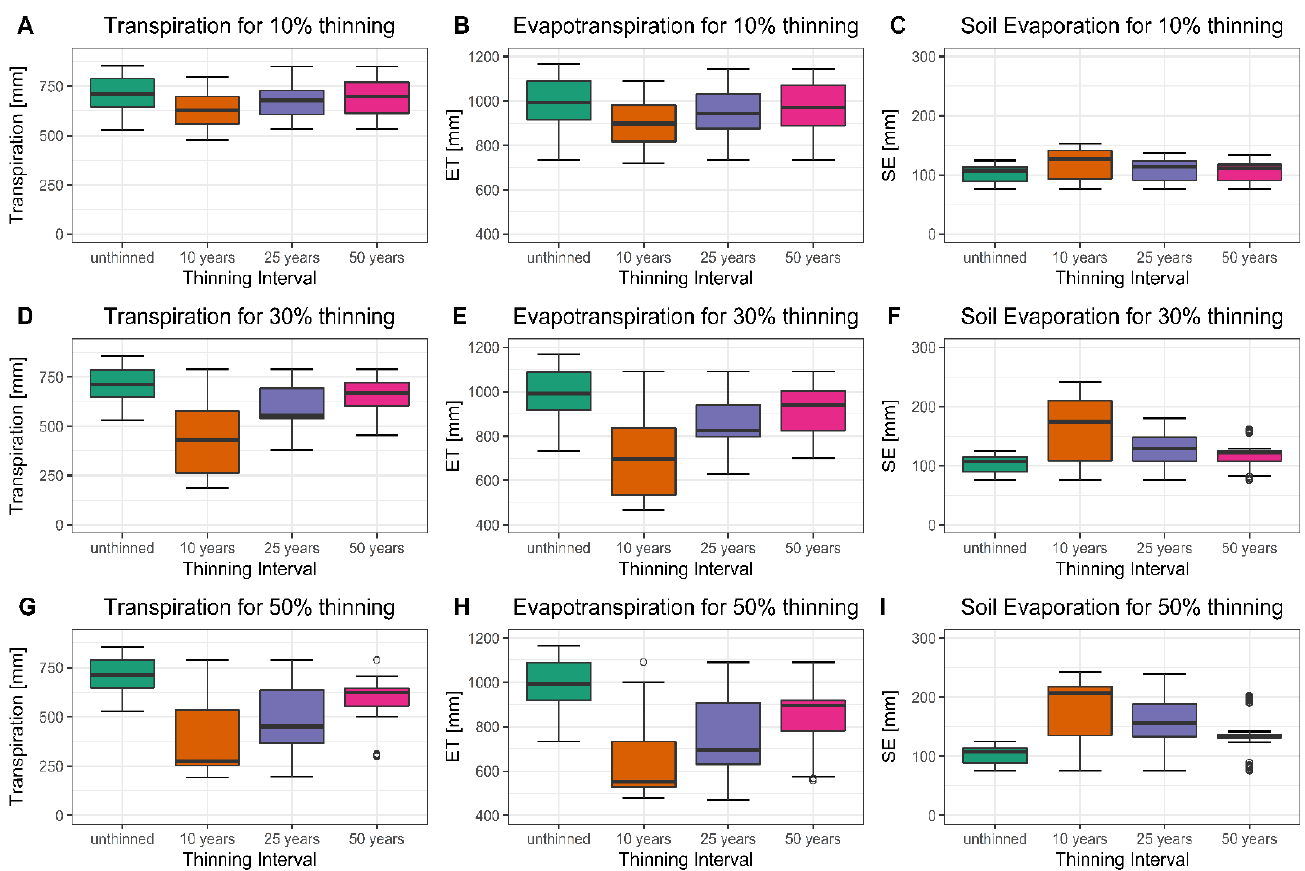
Figure 3. Boxplot for transpiration ( A , D , G ), ET ( B , E , H ) and soil evaporation ( C , F , I ) for 10%, 30%, and 50% thinning, respectively, in different thinning intervals.